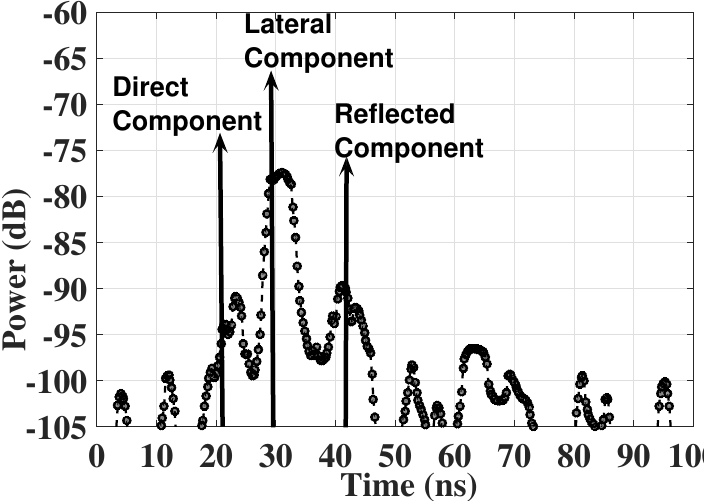
Figure 1. An example power delay profile (PDP) of the impulse response model of the wireless UG channel